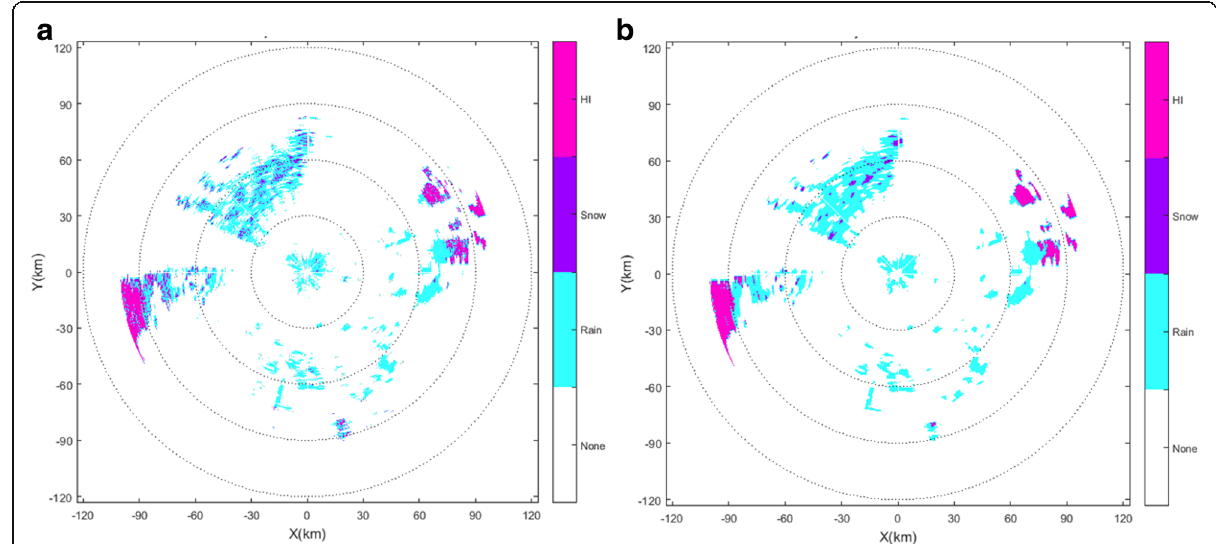
Fig. 5 The classification result of precipitation pattern corresponding to the case of 27 March 2017. a PPI of the classification result of precipitation pattern from the product of dual polarization weather radar. b PPI of the classification results of precipitation pattern from the classification system